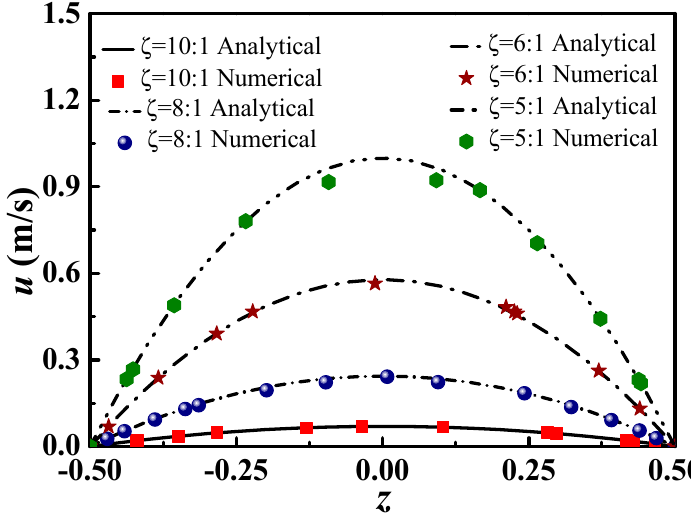
Figure 2. The speed of the middle section along z -direction at different aspect ratios.